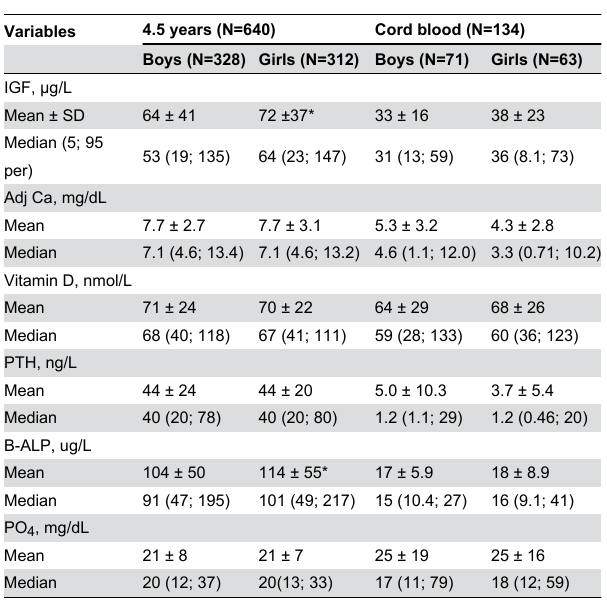
Table 2. Descriptive statistics of plasma growth biomarkers in children at 4.5 years of age and in cord blood, stratified by sex.